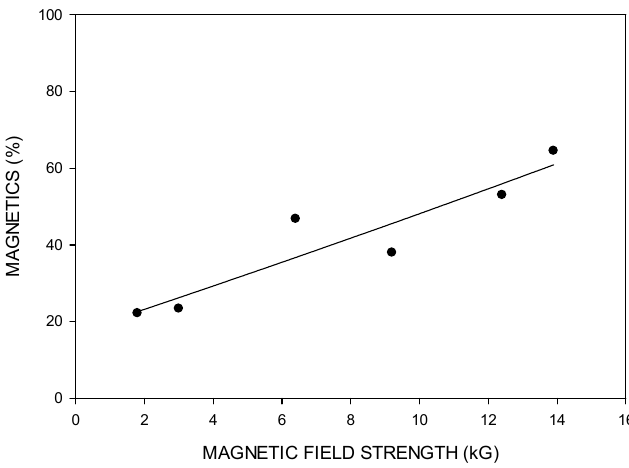
Figure 10. Percent magnetics as a function of magnetic field strength for WHIMS.